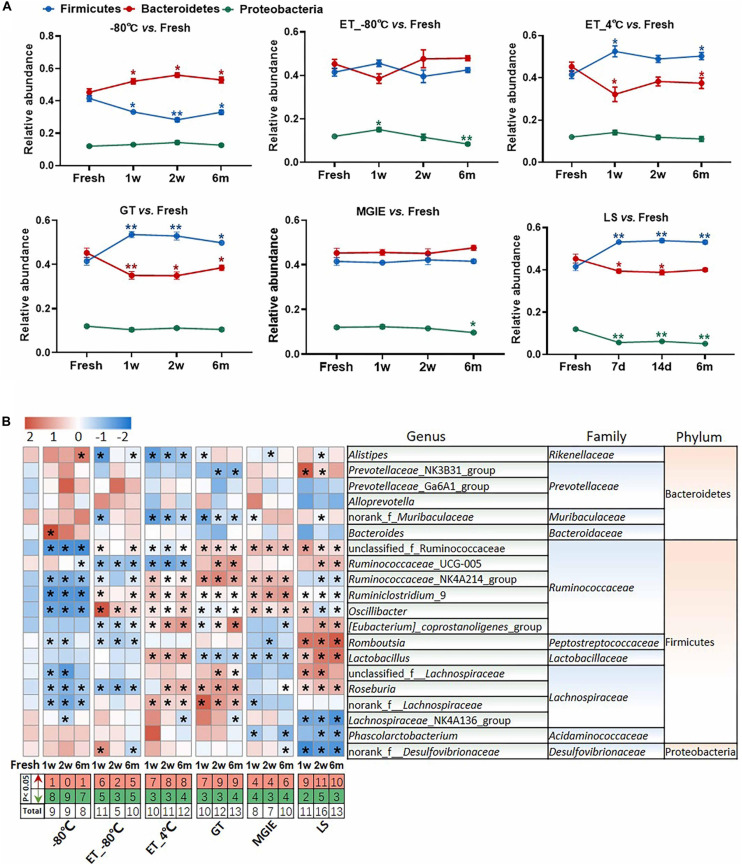
The effect of preservation methods on the dominant bacteria. (A) The effect of storage conditions on the relative abundance of the dominant phyla. (B) The heatmap shown was the differences in relative abundance among groups of the top 20 genera, which accounted for about 85% of coverage, as well as their taxa information including family and phylum. The red and green entries indicate the number of genus that were significantly more or less abundant under different storage conditions relative to fresh samples, respectively. n = 5 per group. *p < 0.05, **p < 0.01, compared with fresh group.